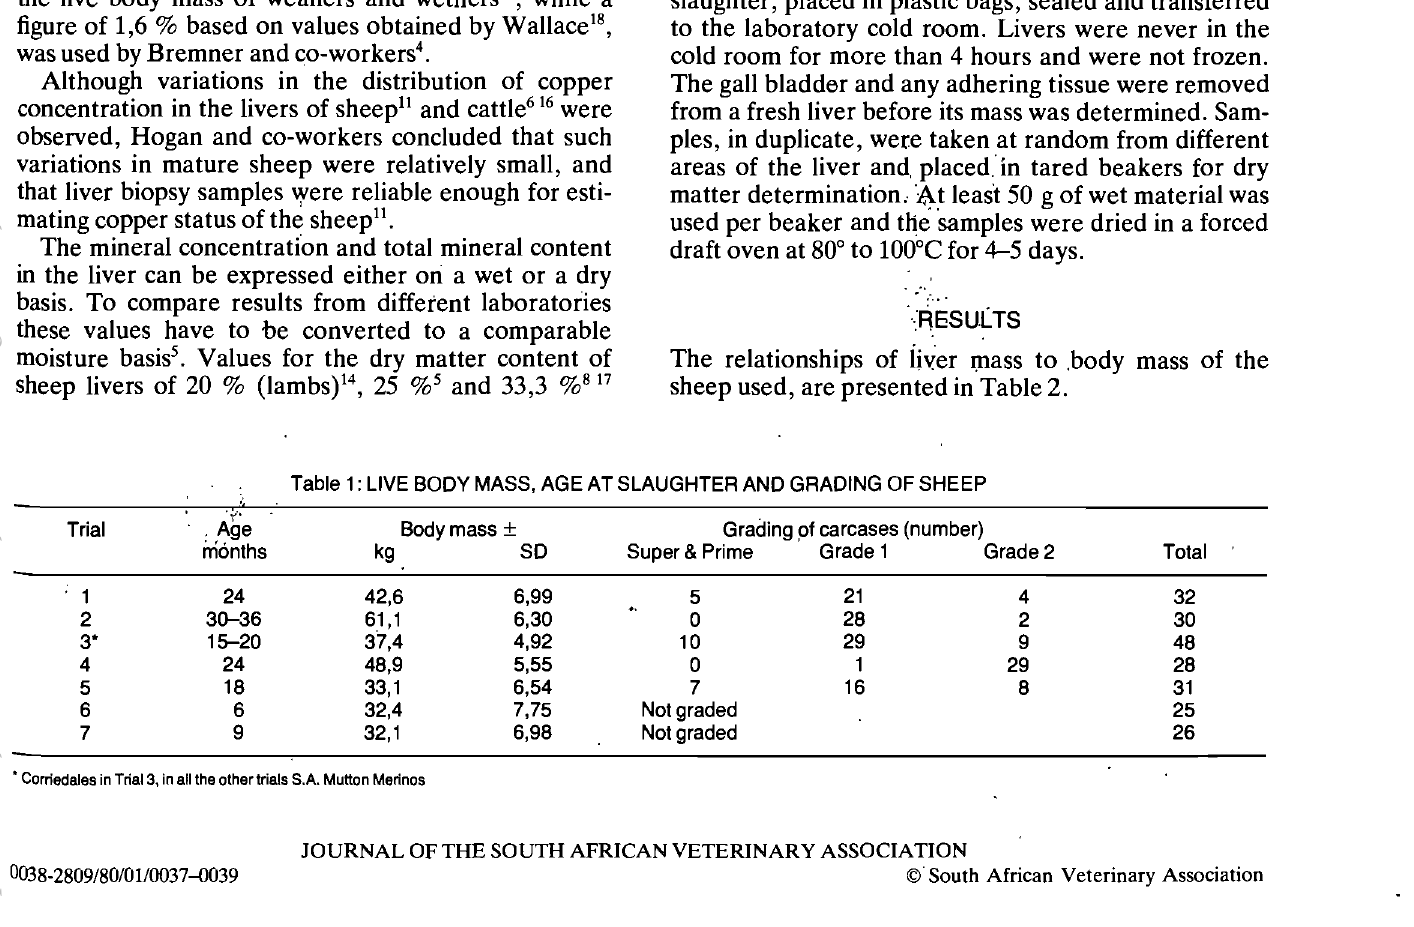
Table 1: LIVE BODY MASS, AGE AT SLAUGHTER AND GRADING OF SHEEP